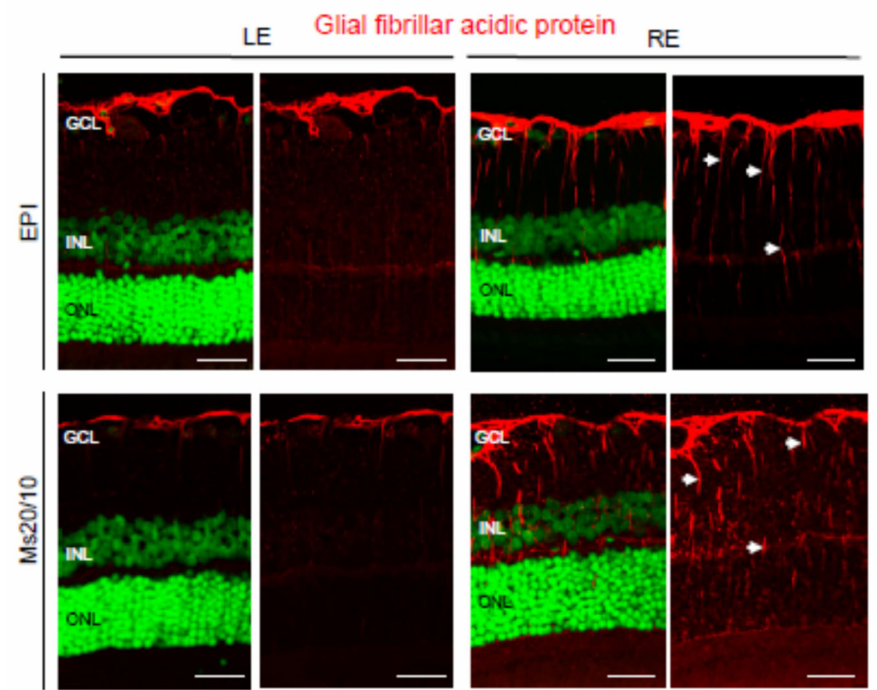
Figure 8. Glial fibrillary acidic protein (GFAP) expression in the glaucomatous EPI (episcleral) and Ms20/10 (microspheres) models. Representative images showed the location and total volume of GFAP observed in the retinas. Note the expression of GFAP in Müller cell processes (arrows) in hypertensive eyes. GCL: ganglion cell layer; INL: inner nuclear layer; ONL: outer nuclear layer; LE: left eye (control); RE: right eye (treated). Scale bar: 30.49 µ m.